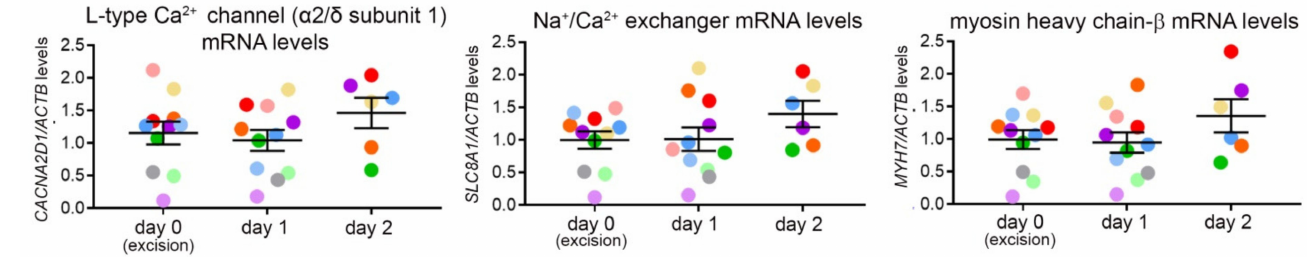
Figure 7. Ventricular CM gene expression over three consecutive days of cell isolation from live cardiac tissue slices of the same heart. Levels of mRNA, encoding L-type Ca 2+ channel α 2/ δ subunit 1, Na + /Ca 2+ exchanger, and myosin heavy chain- β , over three consecutive days of ventricular CM isolation. mRNA levels of the genes of interest are expressed relative to the level mRNA encoding β -actin (control transcript); n = 6–11 hearts/day of isolation. Each colored dot represents the average of data from the same